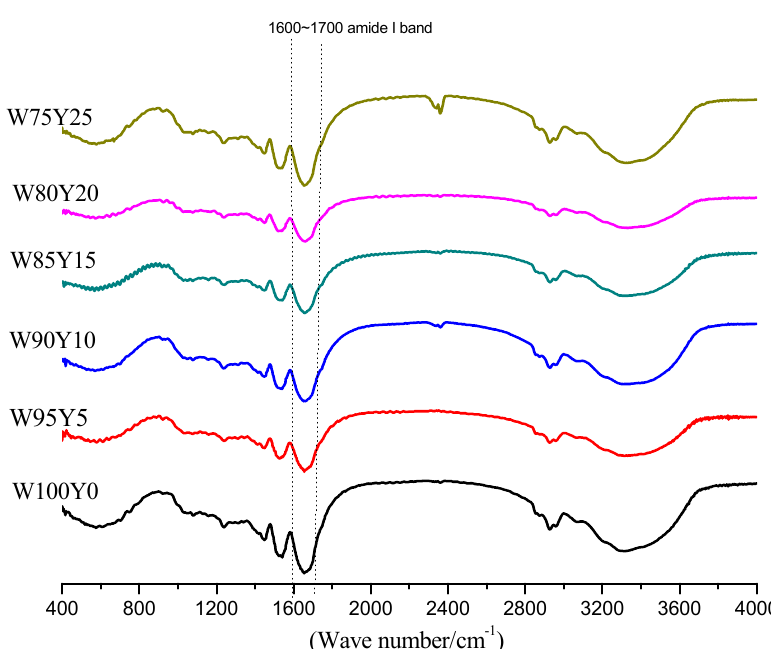
Figure 2. Fourier Transform Infrared Spectroscopy (FTIR) spectra of gluten protein in dough with different amounts of added yam flour.